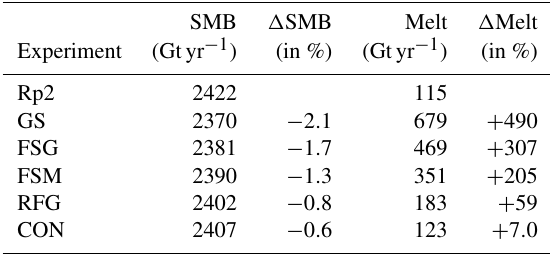
Table A1. Domain-integrated yearly-averaged SMB and melt for the AIS in Gtyr − 1 for Rp2 and the Rp3 sensitivity experiments for 1985–1990. For both variables, the difference with Rp2 in percent- age is also